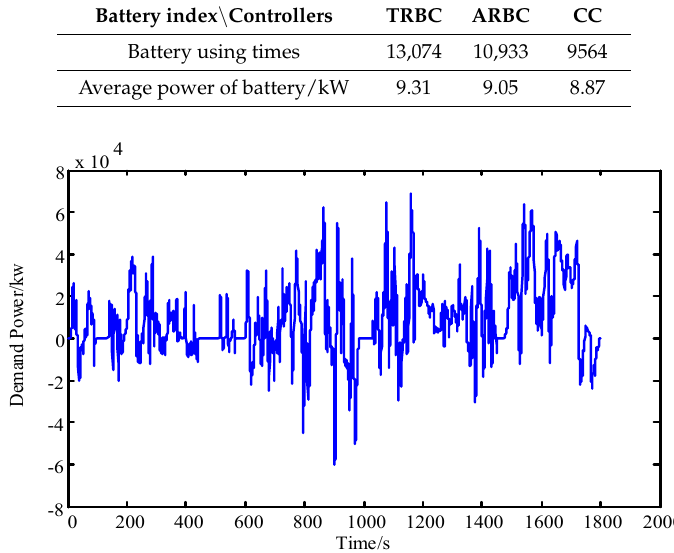
Figure 10. Demand power of WLTP driving cycle.